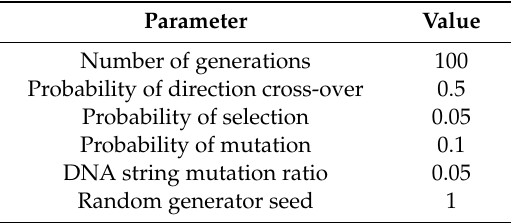
Table 4. MOGA parameters used in this